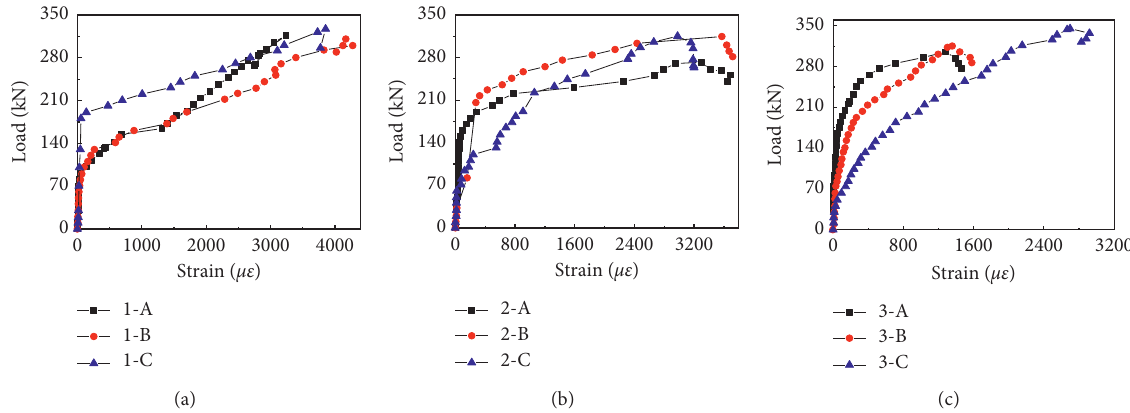
Figure 14: Load-strain curves of LR on left side of the shear key. (a) First group. (b) Second group. (c) Third group.